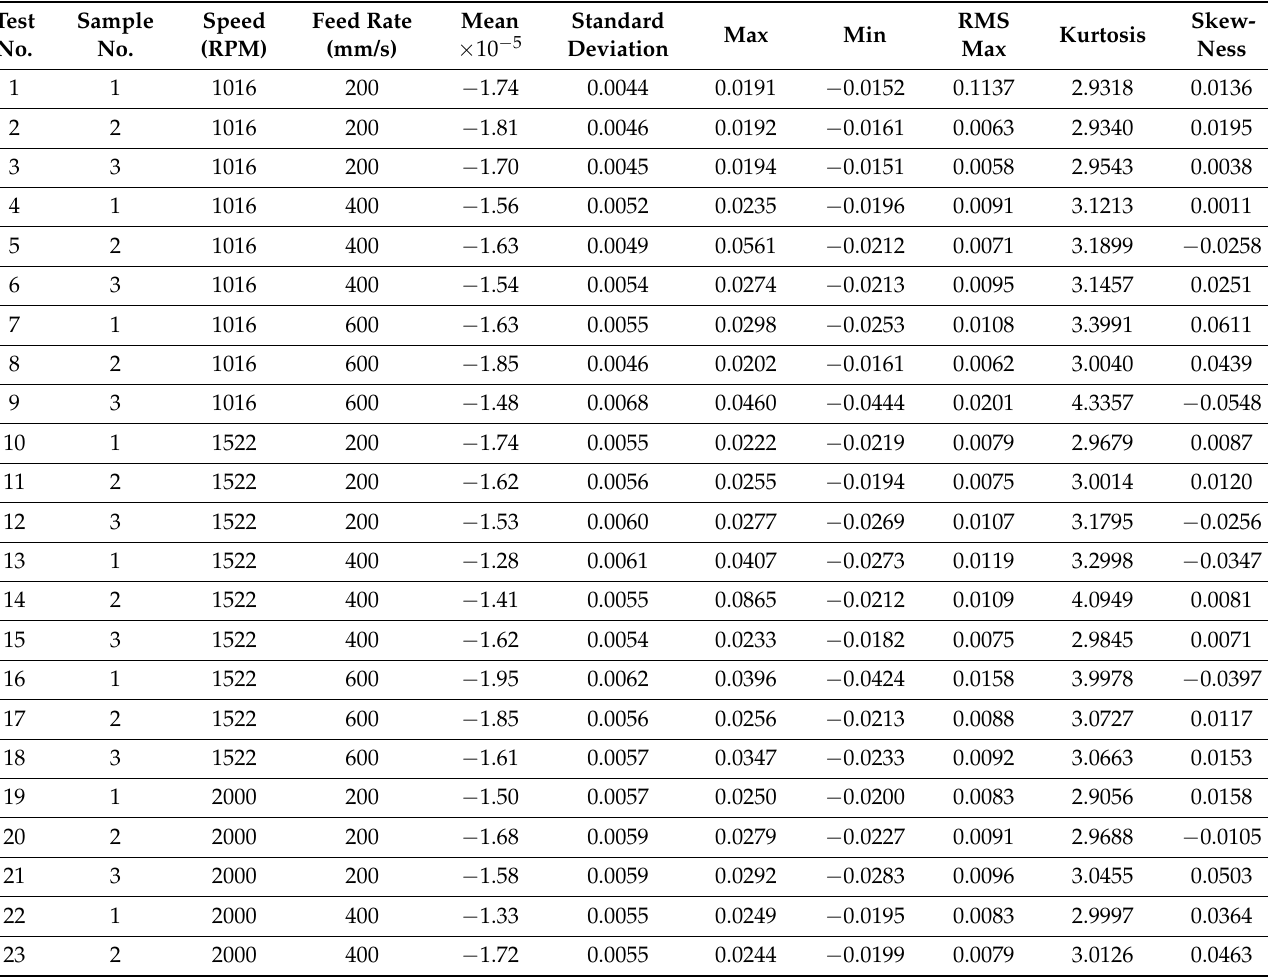
Figure 4. Experimental setup. Table 1. Various features of acquired